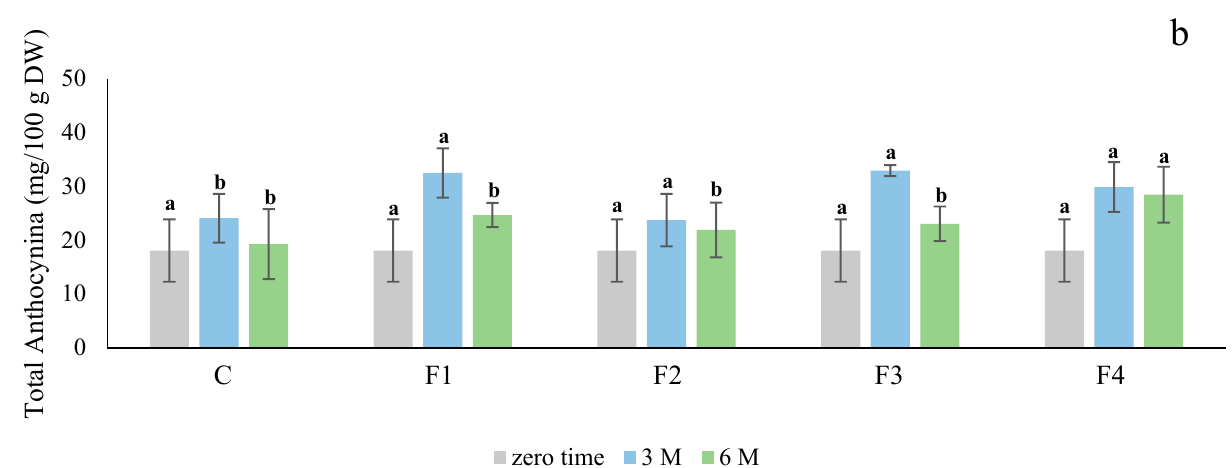
Figure 3. Effect of different edible coatings on total anthocyanin content of Ciklamen ( a ) and Modoc ( b ) after six months of cold storage at 4 ± 2 ◦ C and 90 ± 5% RH. Data are expressed as mean ± SD, n = 3. The different letters are letters on the bars are indicative of statistical significance ( p < 0.05). C: control. F1: sodium alginate. F2: potato starch + sodium alginate emulsion with oregano oil. F3: zein + chitosan emulsion with oregano oil. F4: potato starch + chitosan + sodium alginate emulsion with oregano oil.